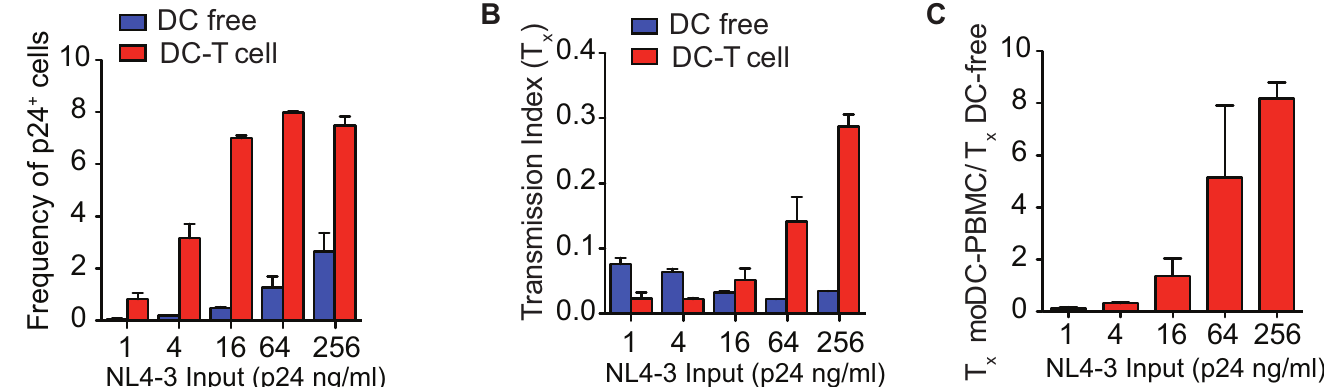
Fig 7. TFV insensitivity of moDC-to-PBMC transmission is dependent on infectious dose of NL4-3. ( A ) PBMCs with or without moDCs were infected with varying doses of NL4-3. Frequency of p24 + T cells was measured by flow cytometry. ( B, C ) PBMCs with or without moDCs were infected with varying doses of NL4-3 in the presence or absence of 10 μM of TFV and drug insensitivity (T x ) (B) and fold difference between the T x values were measured (C). Mean ± s.e.m ( η = 2 donors). Data is representative of two independent experiments ( A-C ).